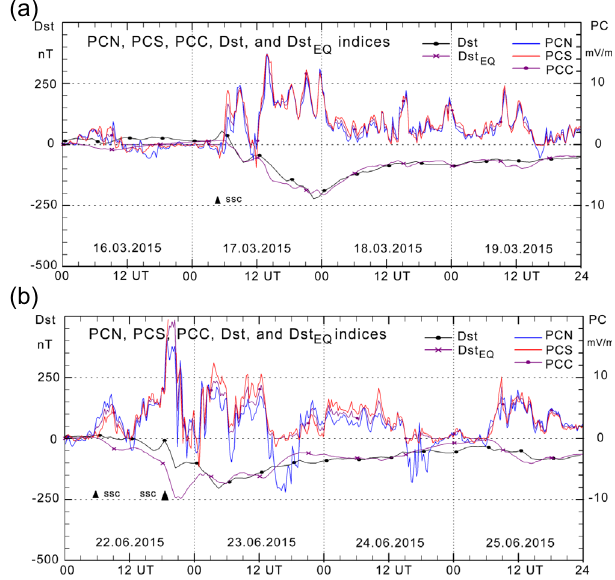
Fig. 14. (a, b) Examples of published (real) Dst (black line, dots) and equivalent Dst (magenta, crosses) values calculated from the PCC- based source function. Values of PCC (magenta), PCN (blue), and PCS (red) are displayed in the upper fi elds on the right